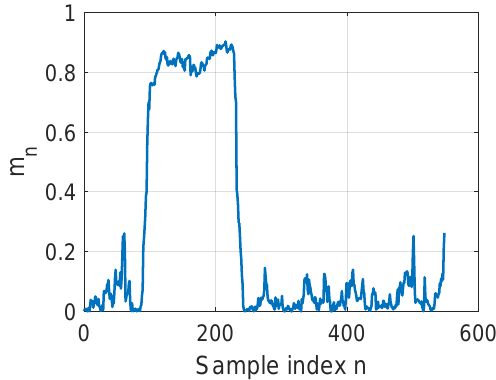
Figure 10. The response of auto-correlation